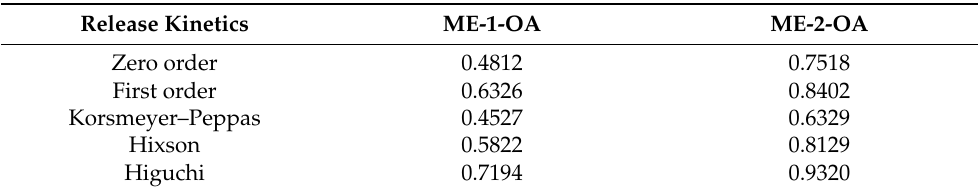
Table 4. Regression coefficient (R 2 ) obtained in different kinetics models for OA release from ME-1- OA and ME-2-OA.